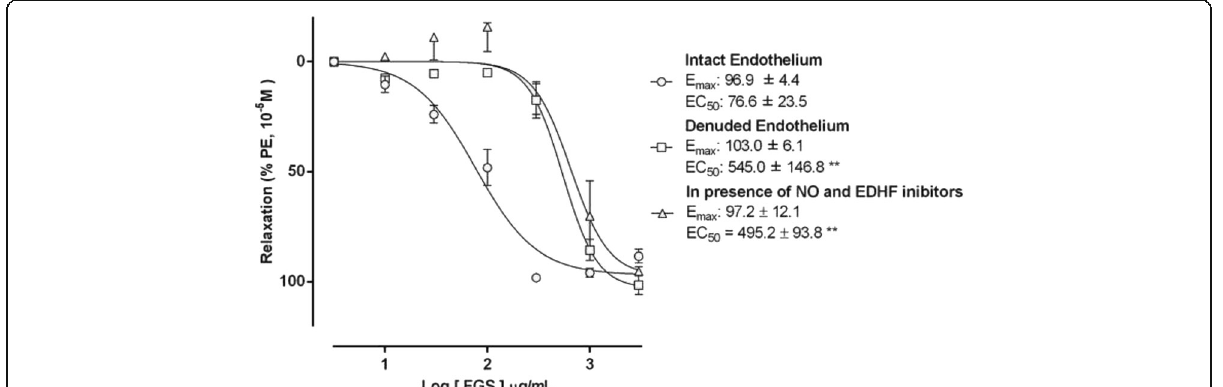
Fig. 2 Vasorelaxant effect induced by fermented (FGS) grape skin extracts (10 – 3000 μ g/mL). The responses were assessed in resistance mesenteric artery rings, pre-contracted with PE 10 μ M in endothelium-intact, endothelium-denuded and in endothelium-intact preparation, pre-incubated with L- NAME (100 μ M) and charybdotoxin (50 nM) plus apamin (50 nM). Data are expressed as mean ± SEM of 5, 4, and 4 experiments, respectively.